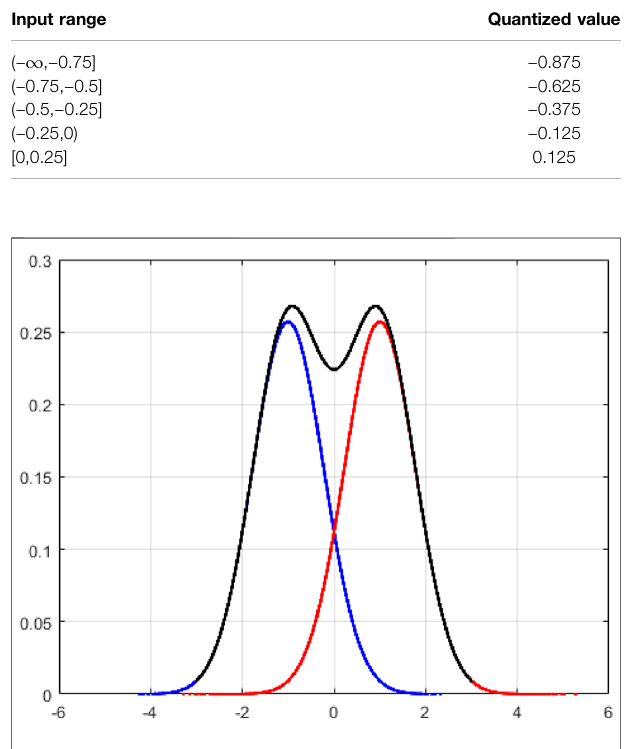
FIGURE 7 | Initial information distribution ( σ 2 n (cid:1)